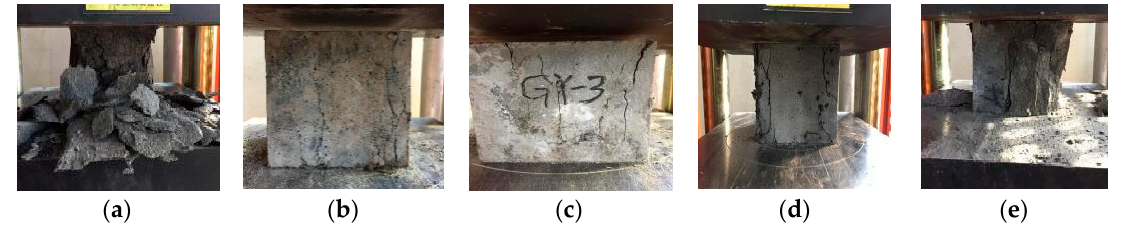
Figure 7. Compressive strength failure mode of polypropylene fiber RPC: ( a ) 0%, ( b ) 0.15%, ( c ) 0.3%, ( d ) 0.45%, and ( e ) 0.6%.